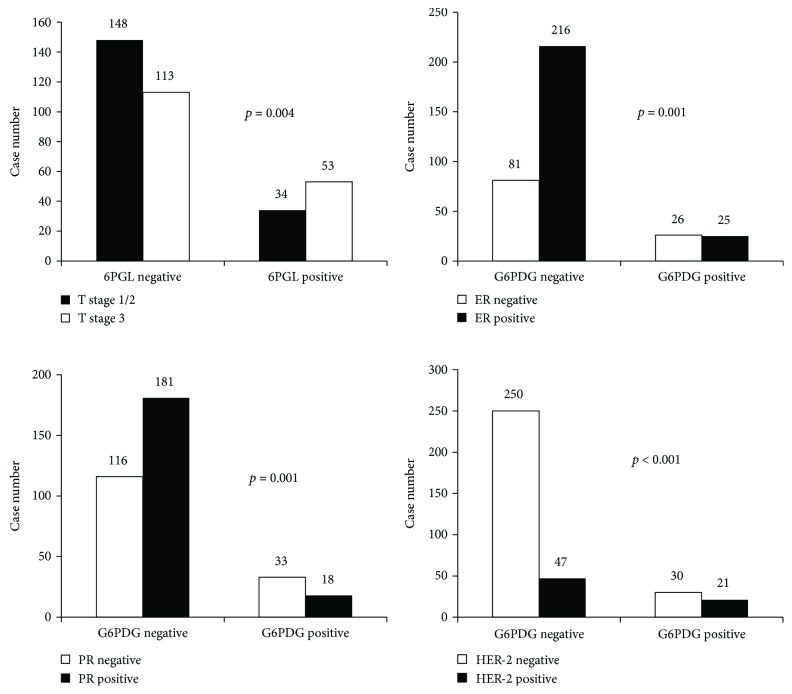
Correlation between expression of pentose phosphate pathway-related proteins and clinicopathologic factors. G6PDH positivity is associated with ER negativity (p = 0.001), PR negativity (p = 0.001), and HER-2 positivity (p < 0.001), and 6PGL positivity is associated with higher T stage (p = 0.004).